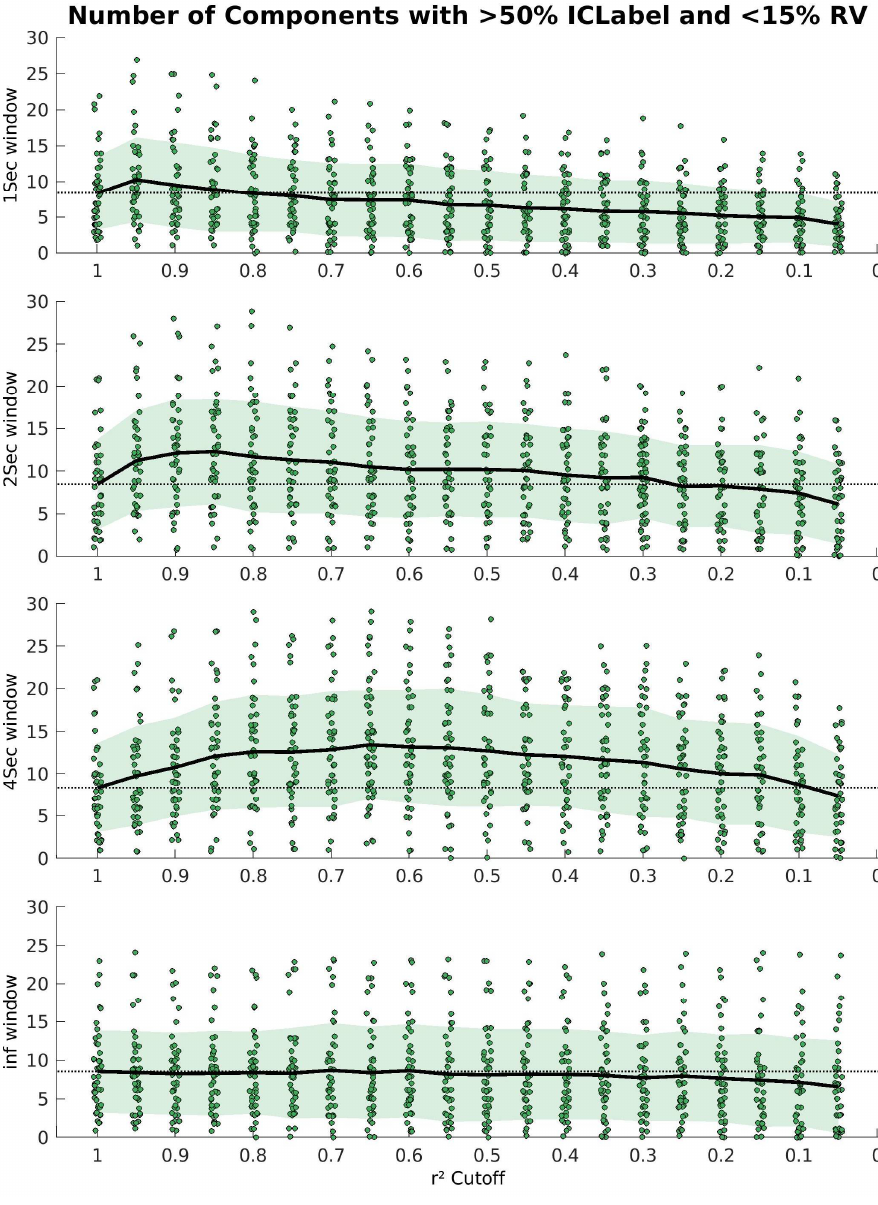
Figure 3. Results from parameter sweep for 1 s, 2 s, 4 s, and infinite windows. The number of high-quality components is plotted against the r 2 cutoff. The average is shown as a thick black line, and the standard deviation is shaded in green. The baseline number of good components is shown as a dashed horizontal line in black. There is a visual increase in the performance in the 2 s and 4 s windows, but the 1 s and infinite windows do not increase much from